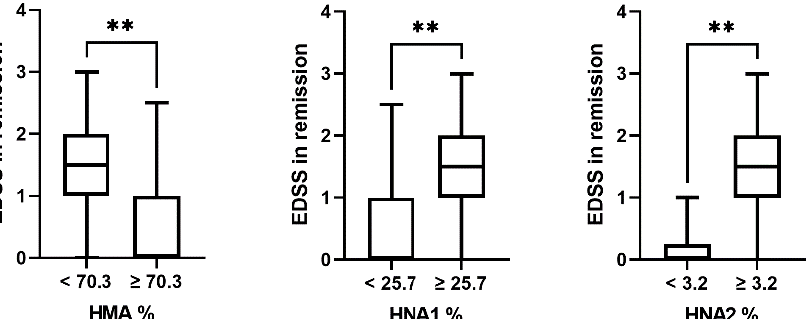
Figure 2. Association of albumin redox state in serum with physical disability in remission. Patients (RRMS and PPMS) were divided into two groups with albumin redox fractions < or ≥ the median serum fraction of HMA (left panel), HNA1 (middle panel), or HNA2 (right panel) in patients and controls. n of the patients in the respective groups: HMA, 11/9; HNA1, 7/13; HNA2, 10/10. **, p < 0.01 by Mann–Whitney U tests.